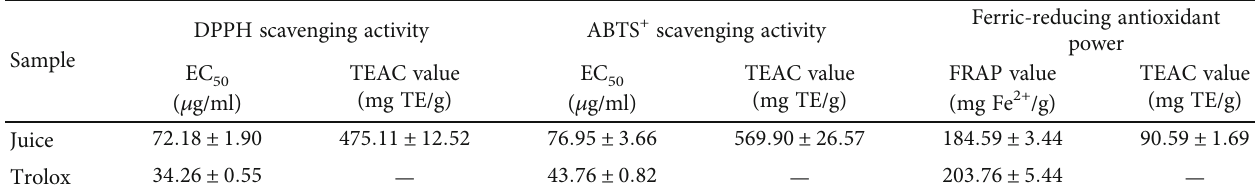
Table 2: Antioxidant activity of Mao fruit juice determined using DPPH, ABTS + , and FRAP testing. Sample